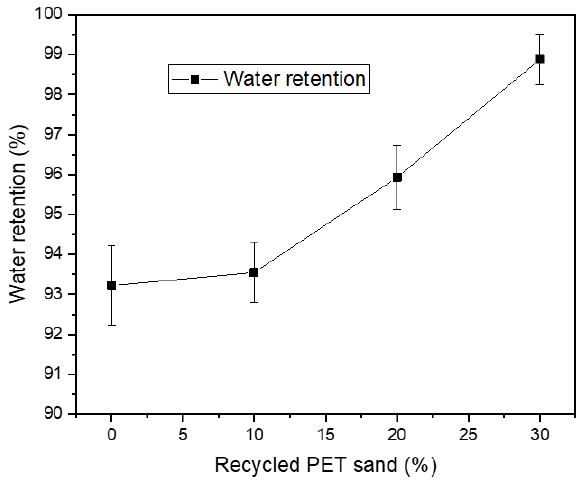
Figure 4. Water retention results.